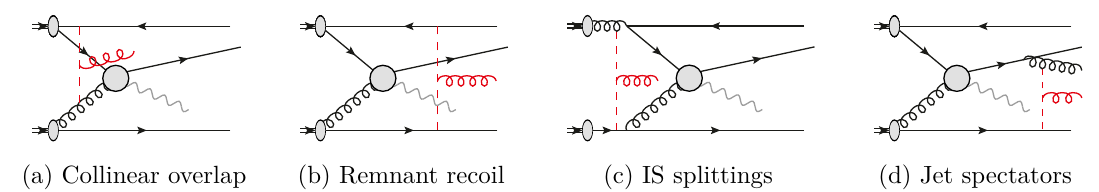
Figure 2. Glauber topologies. Glauber and Lipatov emissions are colored in red, Glauber emissions are dashed. The diagrams describe (a) the collinear overlap of active-spectator interactions, (b) rescattering of the proton remnants, (c) Glauber bursts after perturbative initial state (IS) splittings, and (d) spectator-spectator exchanges involving the jet,